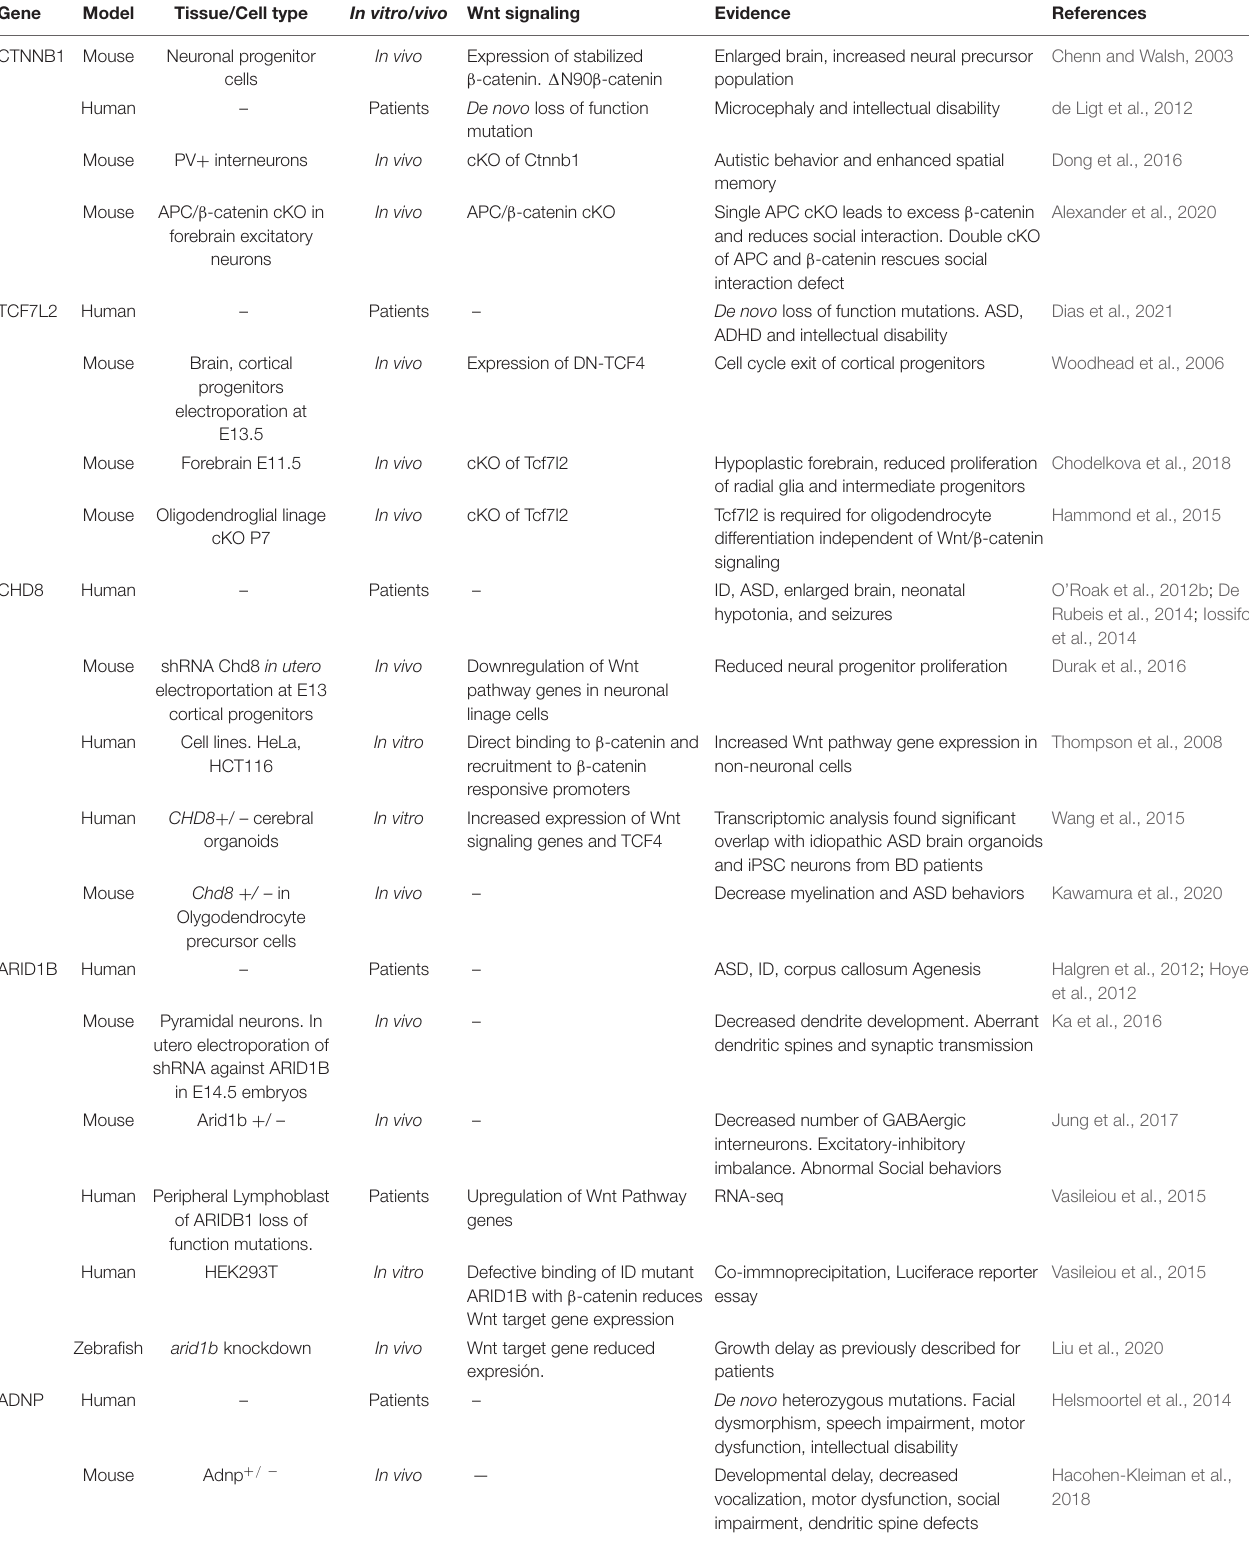
TABLE 1 | Wnt/ β -catenin transcriptional regulators in autism spectrum disorders